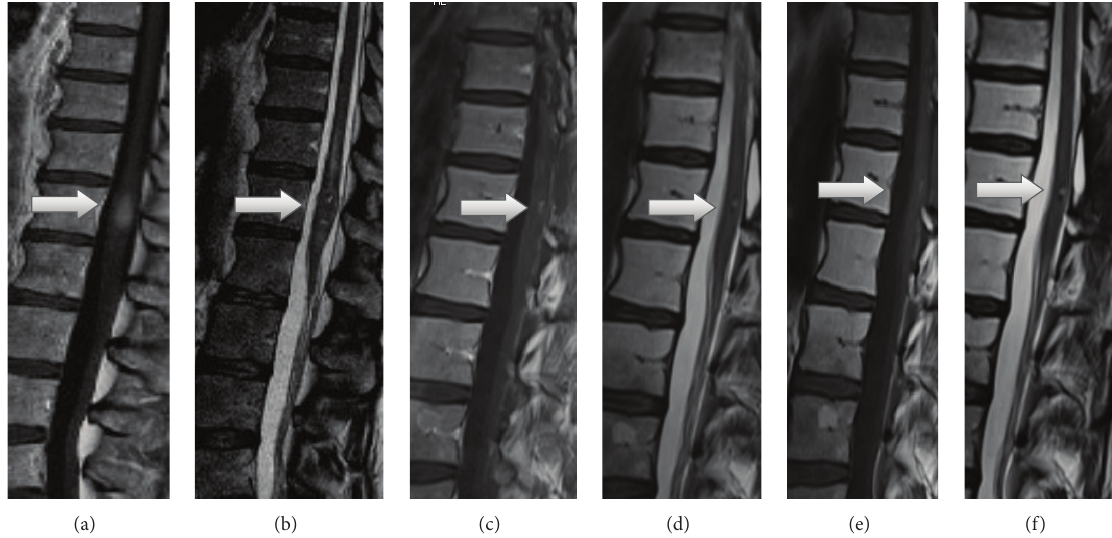
Figure 1: Preoperative sagittal MRI shows the spinal cord tumor at the level of the conus medullaris (arrow). T1-weighted MRI with gadolinium shows high signal intensity relative to that of the cord (a) and T2-weighted MRI shows inhomogenous hypointensive signal (b). Four weeks’ follow-up sagittal T1-weighted MRI with gadolinium (c) and T2-weighted MRI (d) and 28 weeks’ follow-up T1-weighted MRI with gadolinium (e) and T2-weighted MRI (f) show the residual tumor (arrow).